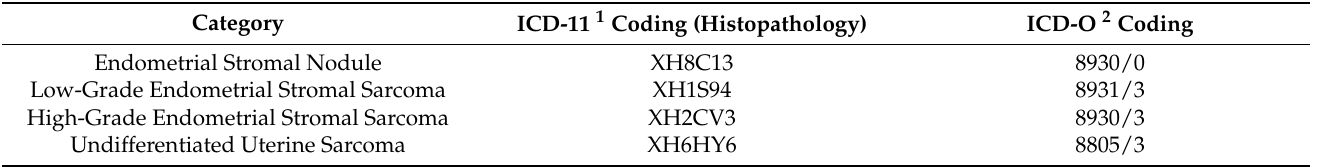
Table 1. The classification of Endometrial Stromal Tumours defined in the fifth edition of WHO Classification of Female Genital